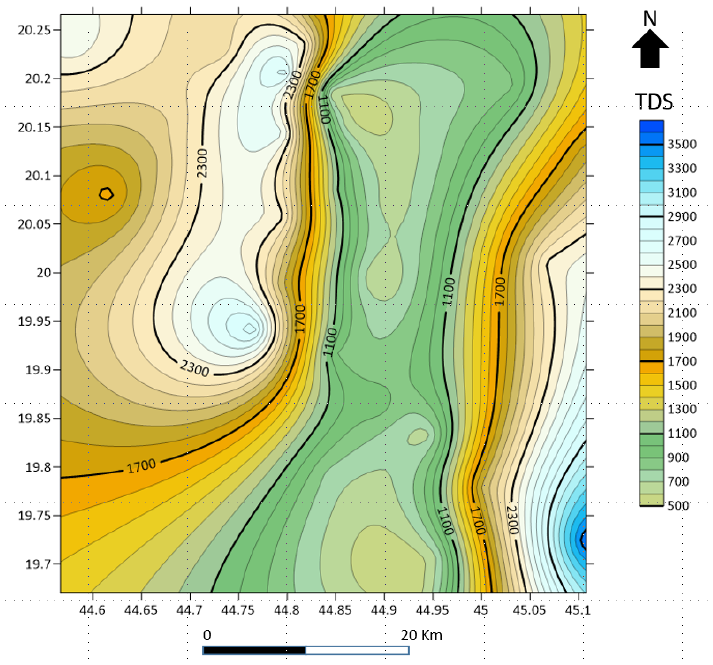
Figure 14. Spatial map shows the distribution of TDS of the studied groundwater. The reverse pattern of TDS (higher values in recharge area) is attributed to agricultural-derived salt deposits that formed due to long and extensive agricultural activity in the study area with aridity climate conditions. In addition, the existence of high-density open fractures within the Wajid aquifer facilitates the downflow of return saline water (Figure 15). The presence of N-S and E-W trending sets of open and vertical fractures within Wajid sandstone (hosting Wajid aquifer), reported in the literature by [25,26].